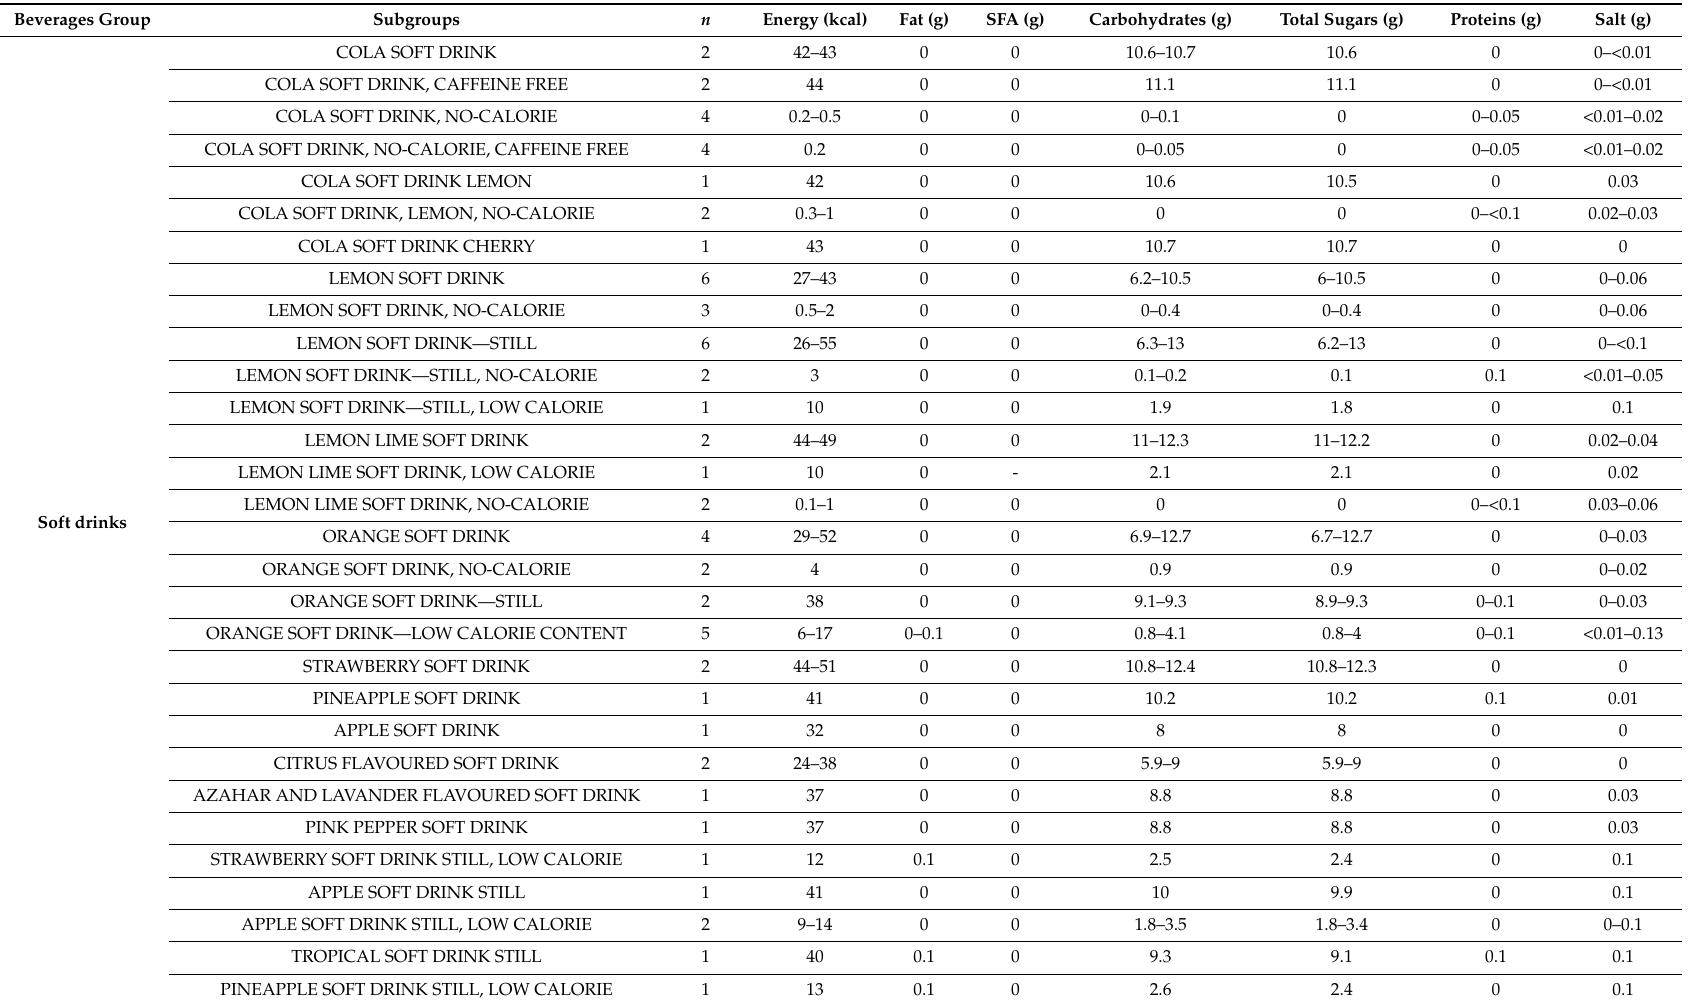
Table 2. Nutrition facts from the “soft drinks” group in the Spanish food